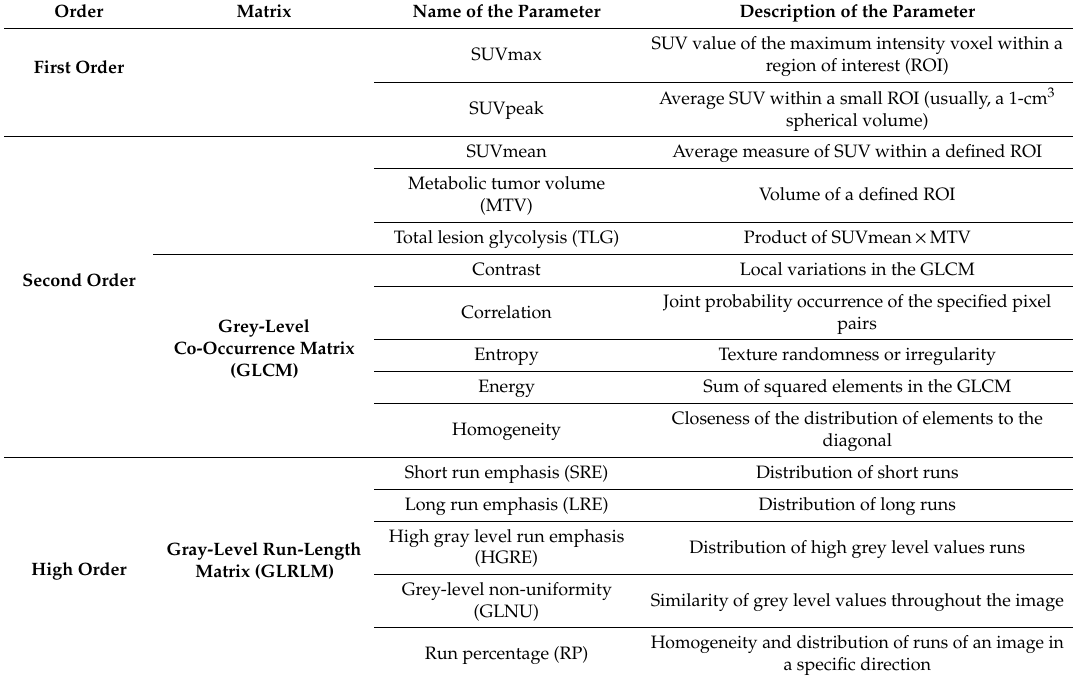
Figure 4. Whole-body 18F-FDG PET scan ( A ) tumor segmentation ( B ) and voxel-intensity resampling ( C ) allowing extraction of different features ( D ) by analysis of consecutive voxels in a direction (for cooccurrence matrices) (a), alignment of voxels with same intensity (b), difference between voxels and their neighbors (c), and zones of voxels with same intensity (d). This research was originally published in JNM [90]. © SNMMI. Table 2. Common imaging heterogeneity parameters. (Based on [61,91]).